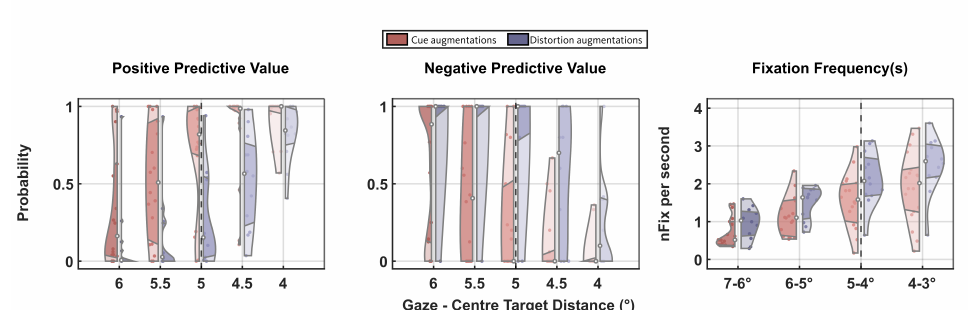
Figure 3. Violin scatter plots for positive and negative predictive values and fixation frequency of all subjects across different distances between gaze and target separated for the cued (red) and optical distortions (blue) augmentations. The black dotted line placed at the value 5° inside the plots indicates the point from which a plateau is starting to emerge for the positive and negative predictive values when considering the monocular augmentations. Furthermore, for the fixation frequency shows where the fixation frequency remains within the two fixations per second range. The plateau and the increase in fixation frequency are starting to emerge below